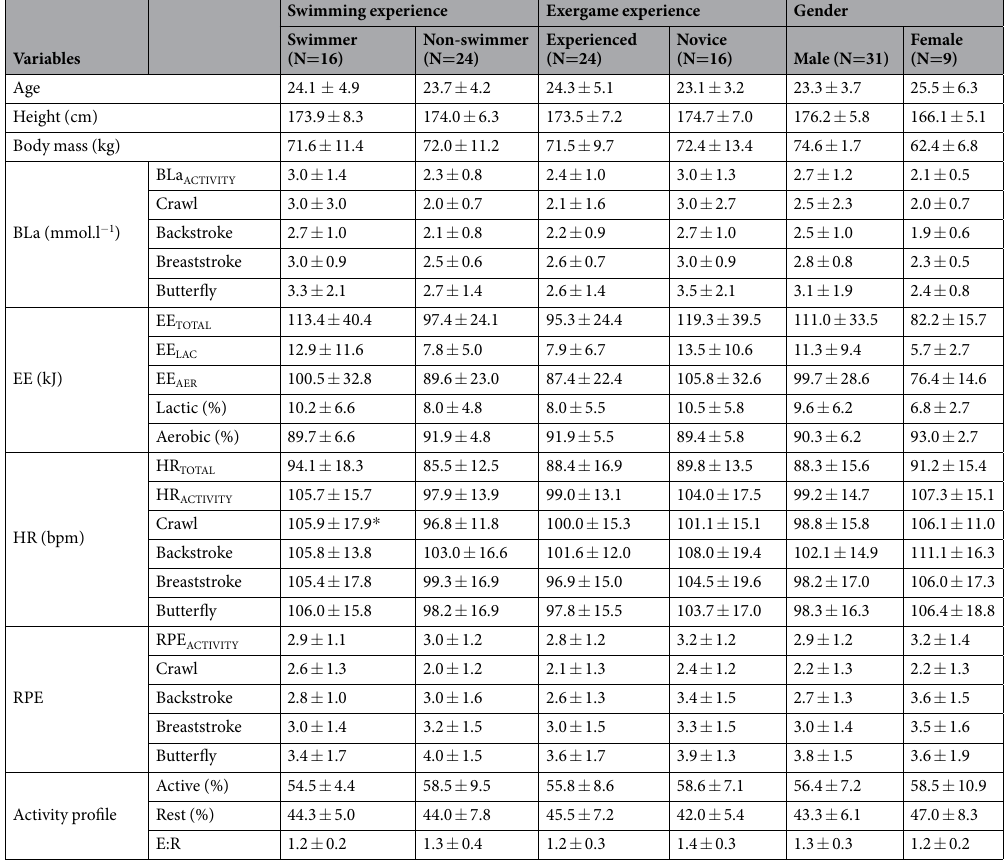
Table 1. Mean ± SD physiological parameters and activity profile in different exergame performing groups.